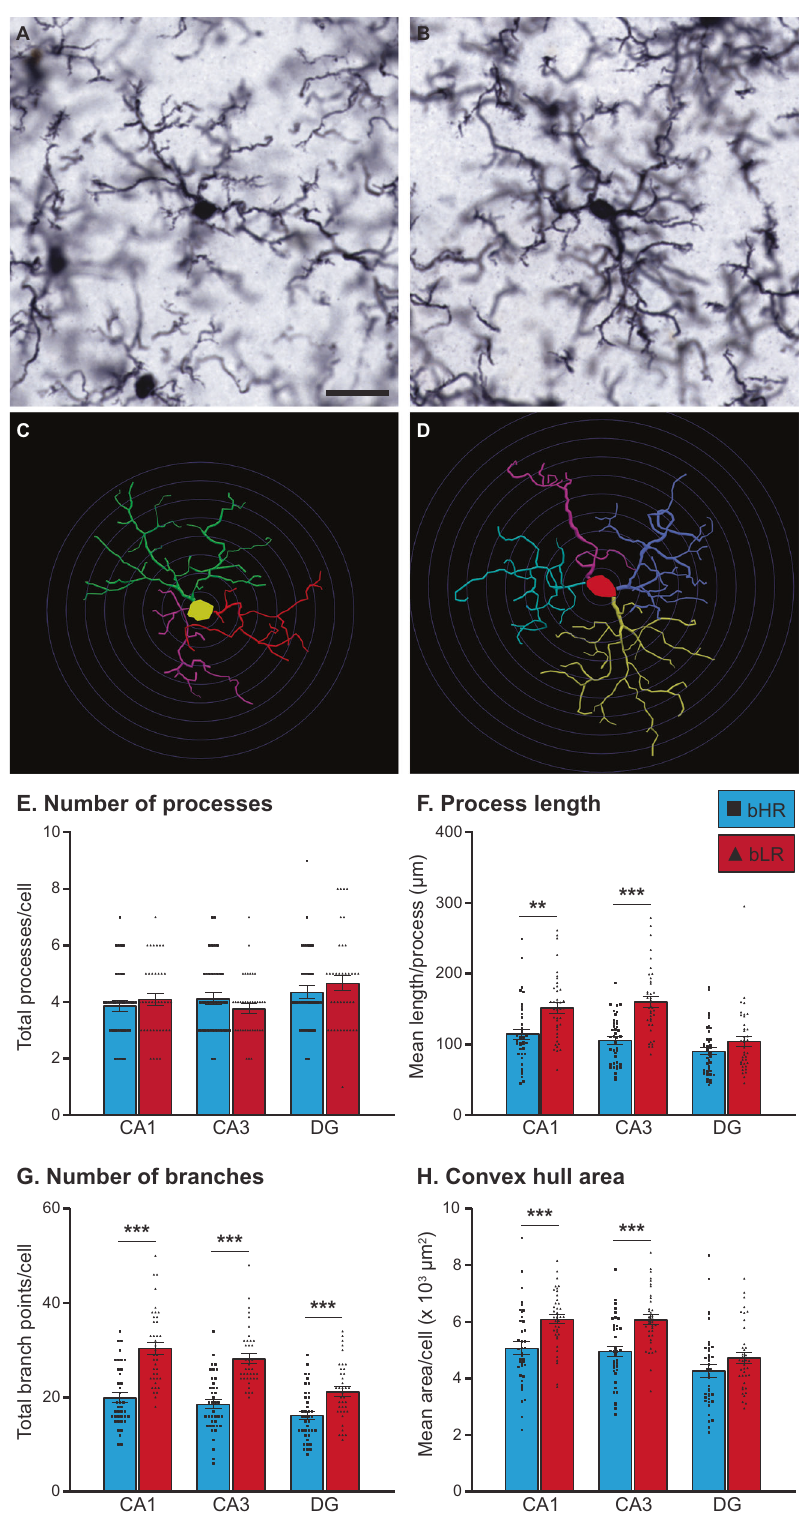
bLRs had longer processes, with more complicated branching patterns, and larger overall territories, an overall morphological pattern consistent with hyper-rami fi